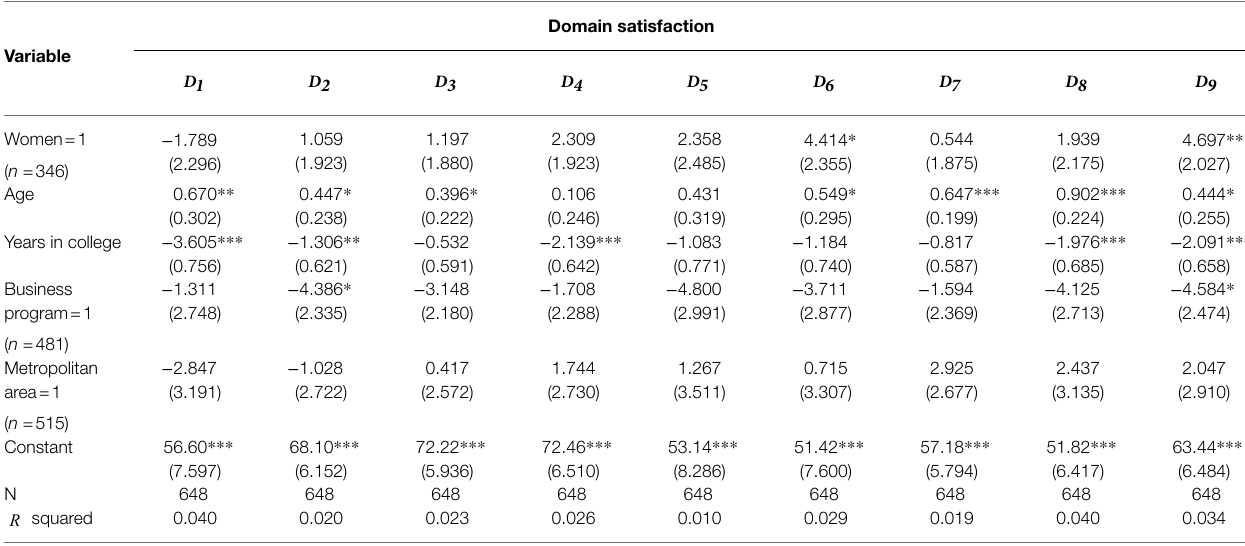
TABLE 2 | Two-layer method, first layer: predictors of domain